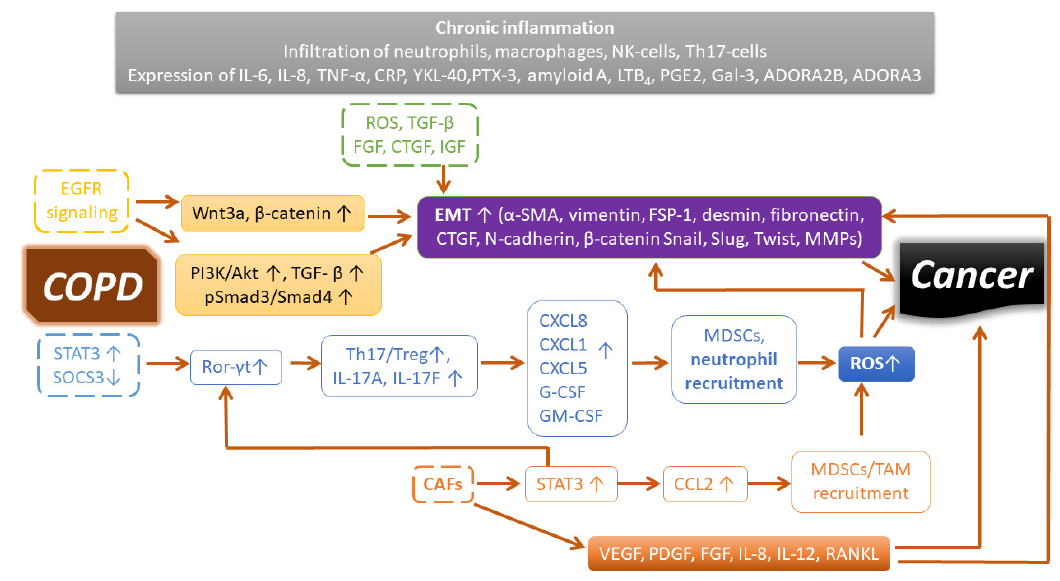
Figure 1. Signaling pathways and inflammatory mediators sustaining a cancer-prone microenvironment in COPD. See explanation in the text.